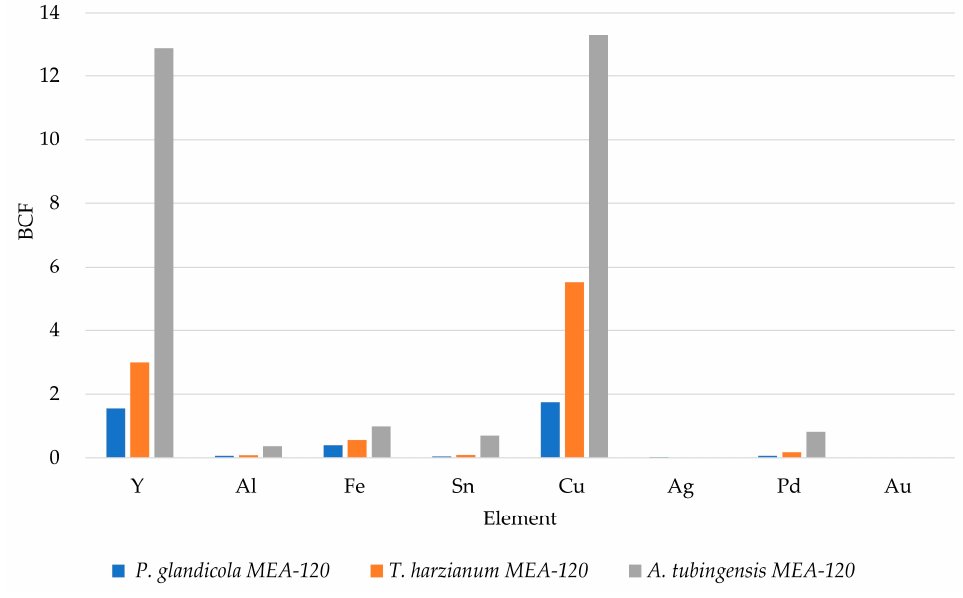
Figure 3. Bioconcentration factor